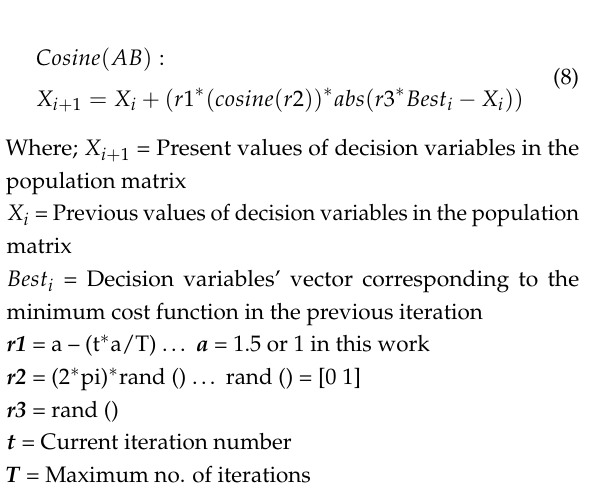
is absent here. Another difference is that in SCA, both sine and cosine terms are integral parts whereas, in